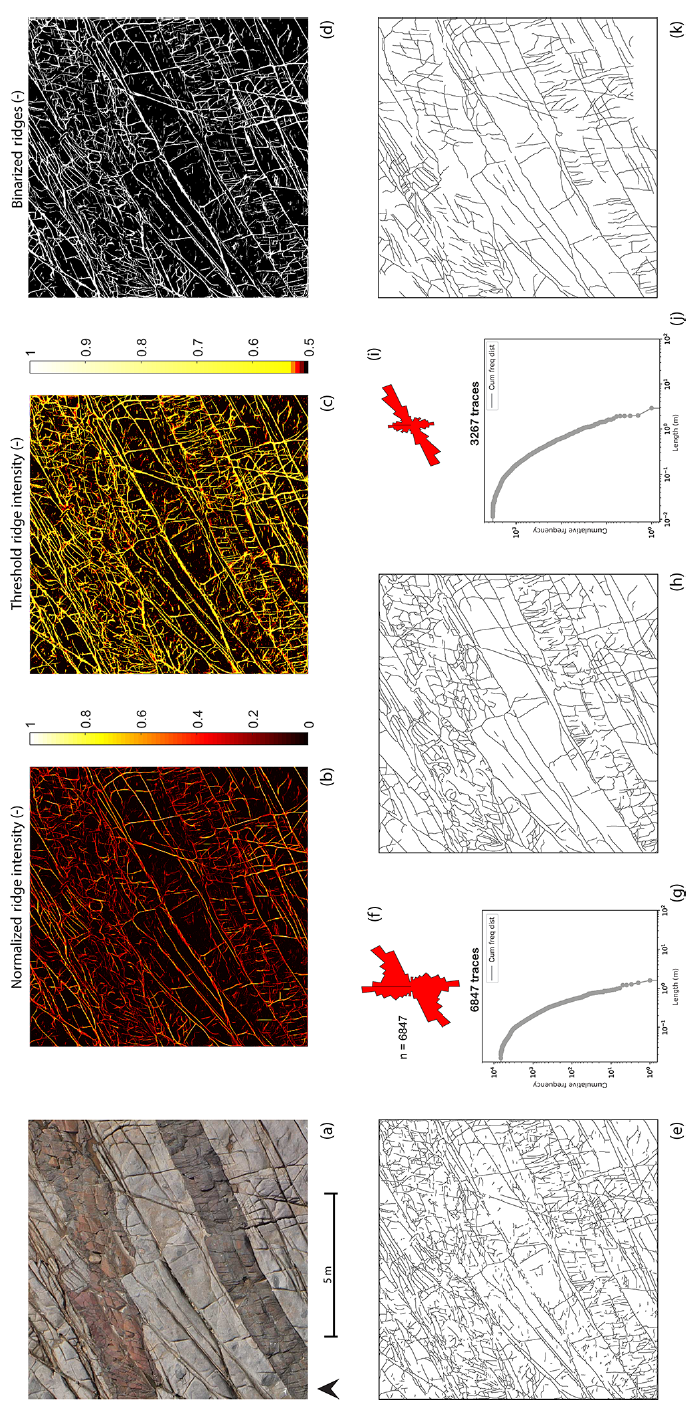
Figure 15. Comparison of benchmark image 2 (a) Bingie Bingie area 2 from Thiele et al. (2017a). This image is available for download at https://doi.org/10.4225/03/5981b31091af9 (Thiele et al., 2017b) under a CC-BY-4.0 license. (b) Normalized ridge map using complex shearlet automatic extraction. (c) Threshold applied to the normalized ridges. (d) Binarized ridges map. (e) Vectorized automatic traces. (f) Length-weighted rose plot of the automatic interpreted traces. (g) Cumulative frequency plot of the automatic interpreted traces. (h) As- sisted cleaned-up trace map for area 2. (i) Length-weighted rose plot of the assisted traces. (j) Cumulative frequency plot of the assisted traces. (k) Assisted trace interpretation modified from Thiele et al. (2017a) for